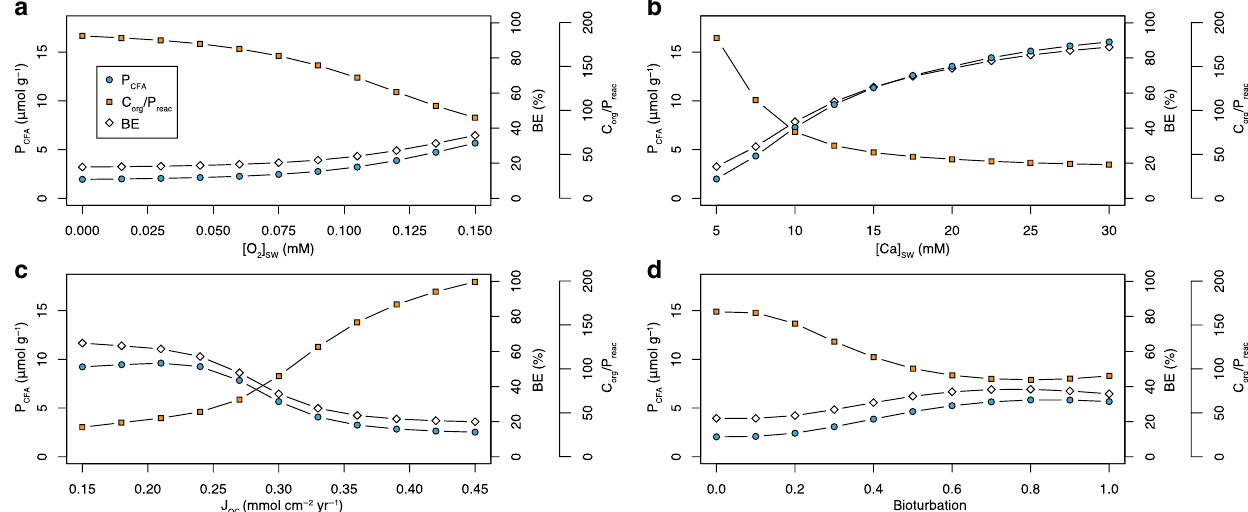
Fig. 2 Nonlinear effects on CFA, total P burial, and C org /P reac . P CFA (circles) represents burial concentration of CFA-associated phosphorus in marine sediments. BE (diamonds) represents the burial ef fi ciency of reactive phosphorus in marine sediments. C org /P reac represents the burial ratio between organic carbon and reactive P. a – d The effects upon P CFA , BE, and C org /P reac of bottom-water oxygen concentration a , seawater dissolved calcium concentration b , fl ux of organic carbon to the sediment – seawater interface (J oc ) c , and bioturbation d . For bioturbation, the four parameters included in the model (DB 0 , a 0 , xbt, and xbi) were increased linearly from zero to modern average values, whereas a linear increase of 16% was applied to